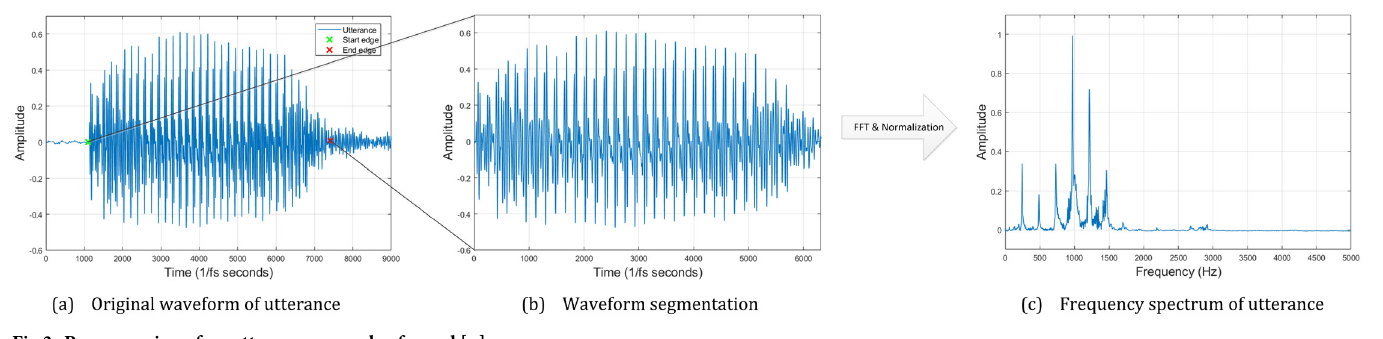
Fig 3. Preprocessing of an utterance example of vowel [ ɑ